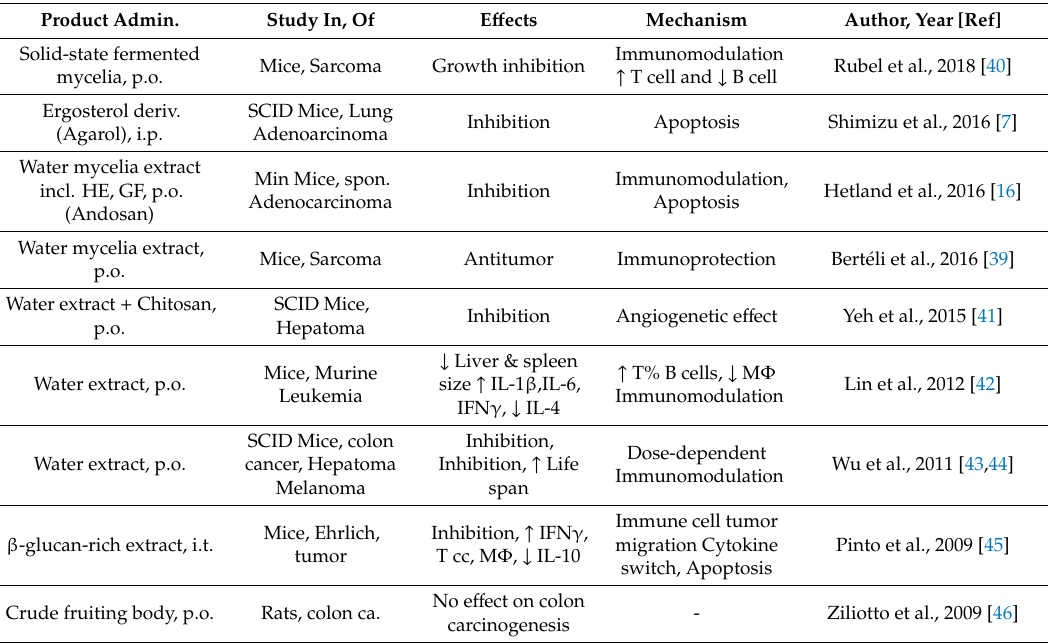
Table 1. Antitumor e ff ects of Agaricus blazei Murill—Preclinical studies. Product